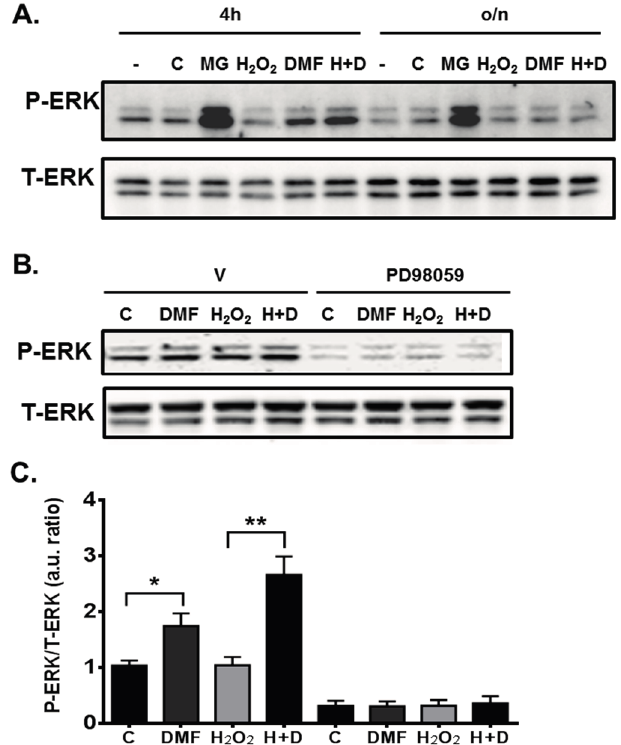
Figure 4. Involvement of ERK1/2 MAPK in DMF-mediated neuroprotection. ( A )